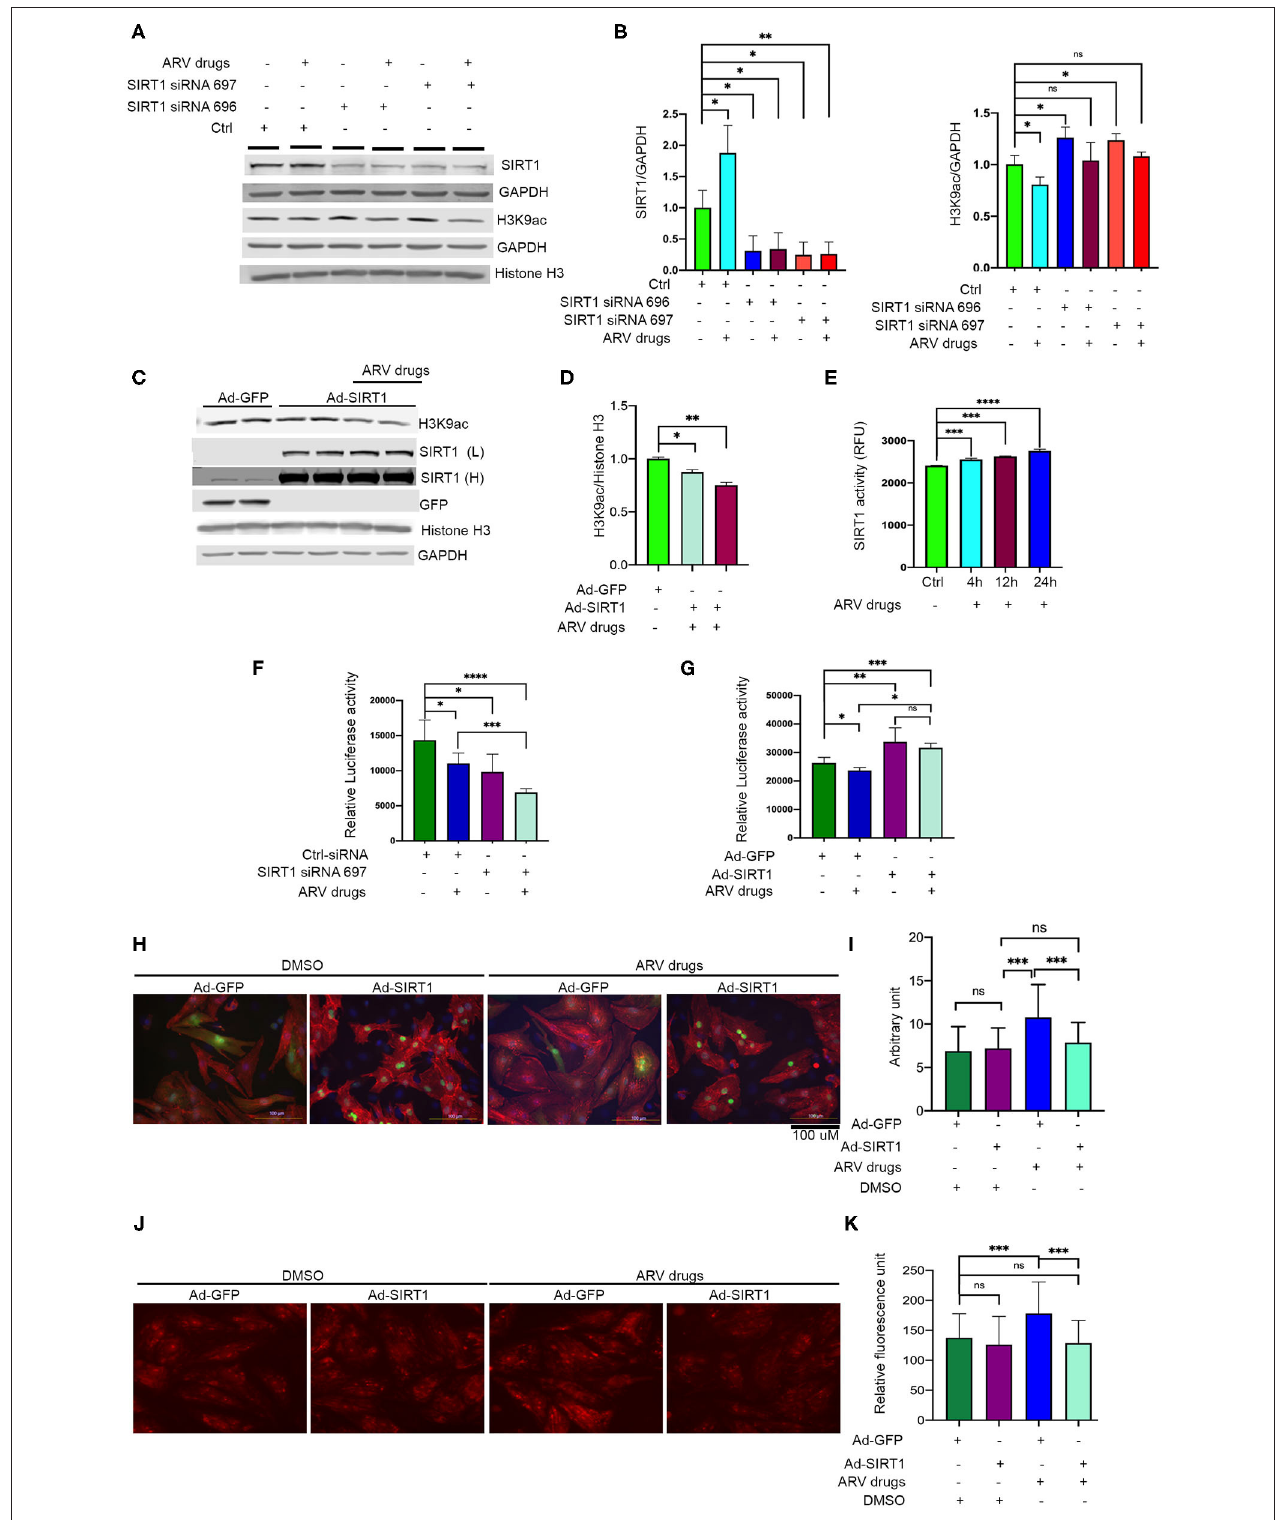
FIGURE 6 | Expression of SIRT1 is critical in ARV drugs mediated modulation of cellular acetylation. (A,B) Western blots show that knockdown of SIRT1 upregulate acetylation of histone at H3K9. NRVCs were treated with SIRT1 siRNA for 48h and followed by ARV drugs treatment (5 µ M of Ritonavir, Abacavir, Atazanavir,